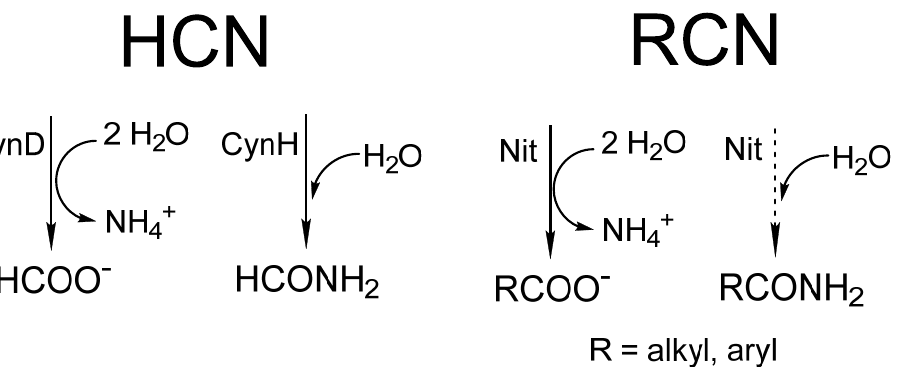
Figure 1. Conversion of hydrogen cyanide (HCN) by cyanide dihydratase (CynD) or cyanide hydratase (CynH), and conversion of nitriles (RCN) by nitrilase (Nit). CynHs also convert some nitriles at lower rates than those of HCN [2]. Unlike CynDs or CynHs, Nits include several subgroups with different substrate specificities [1].